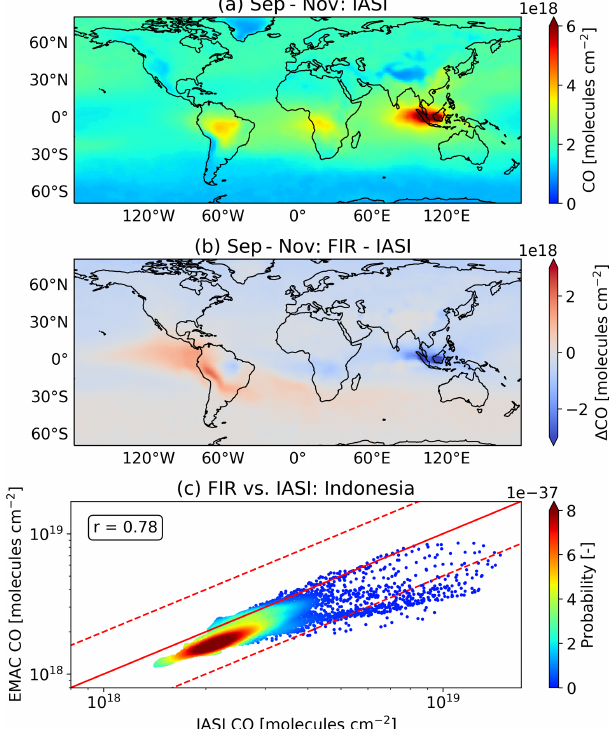
Figure 6. CO comparison between IASI and FIR. (a) Mean global observed IASI CO columns for September to November. (b) Mean global CO column comparison between FIR and IASI for Septem- ber to November. (c) Scatter plot for direct comparison between FIR and IASI over Indonesia for September to